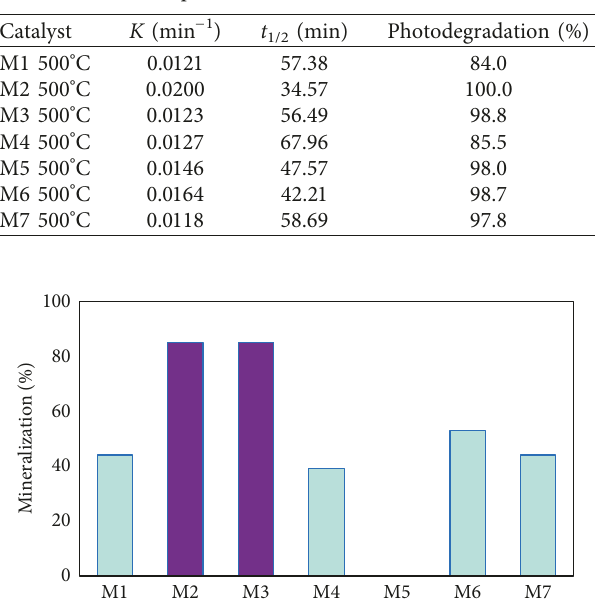
Figure 15: TOC removal during photodegradation of a 2,4,6- trichlorophenol solution.